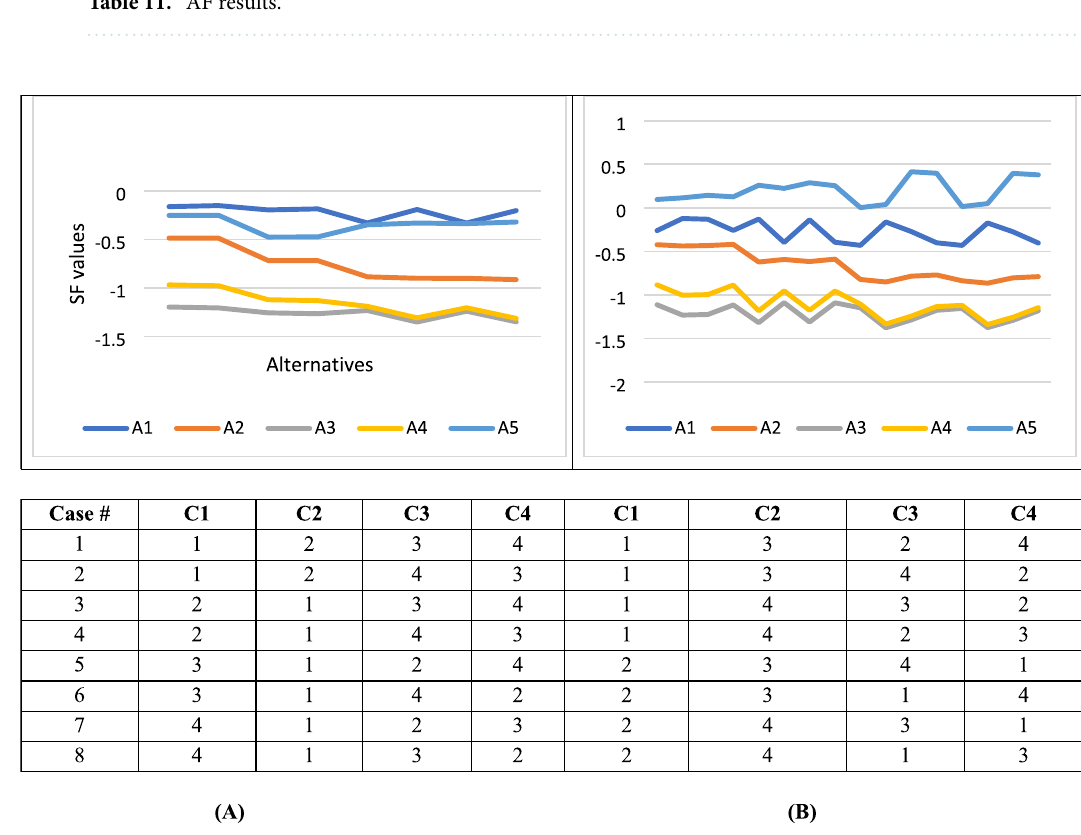
Table 11. AF results.